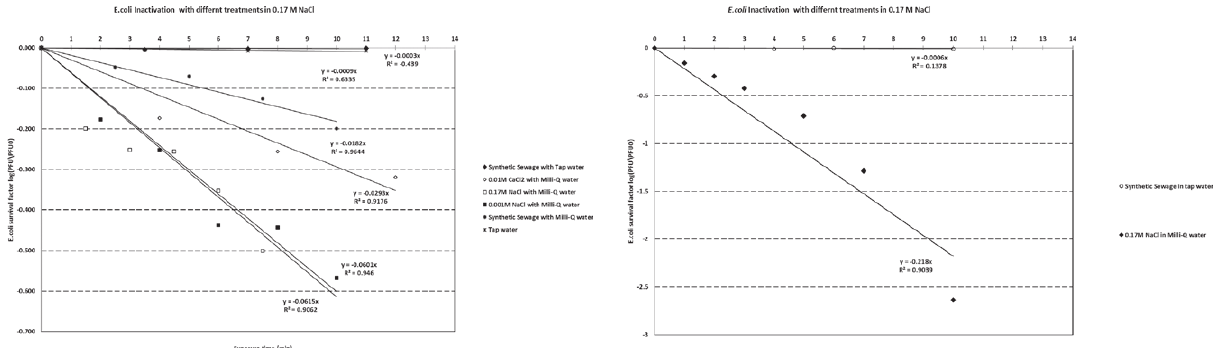
Figure 1. (a) Comparison of E. coli inactivation with CO2 at 38 °C in a bubble column in 6 different solutions; (b) E. coli inactivation with combustion gas at 60 °C in a bubble column in 2 different